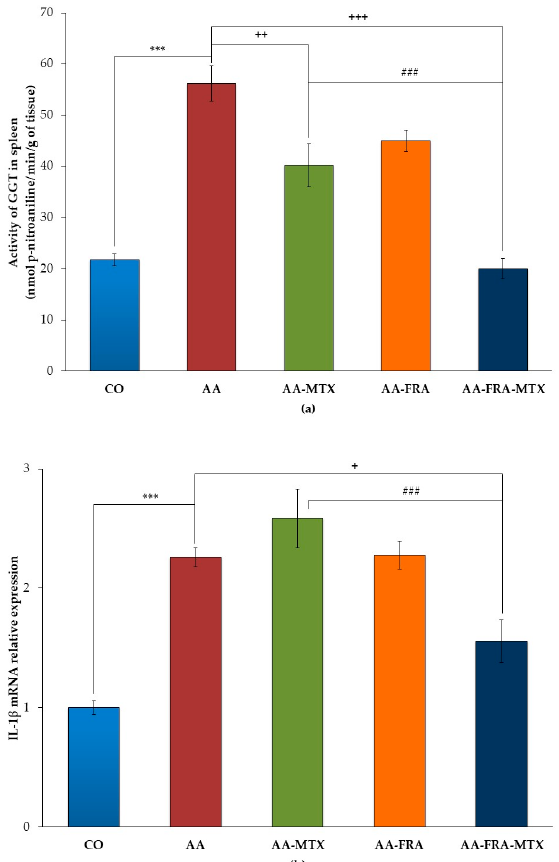
Figure 1. Effect of FRA and MTX administered alone or in combination on the activity of γ -glutamyl transferase (GGT) ( a ) and IL-1 β mRNA relative expression ( b ) in spleen on the experimental day